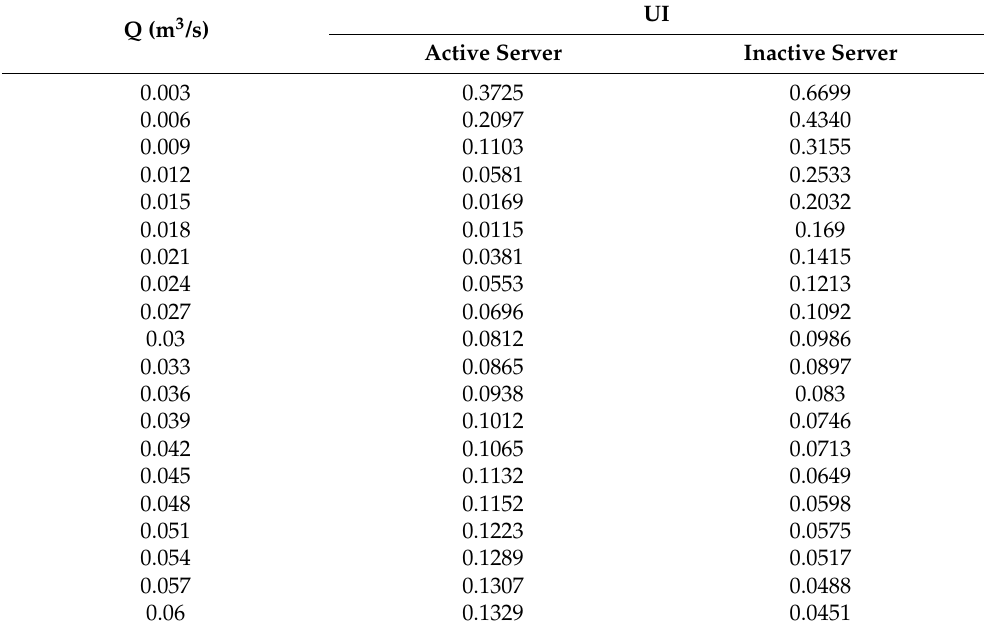
Table 4. Uncertainty indexes for active and inactive